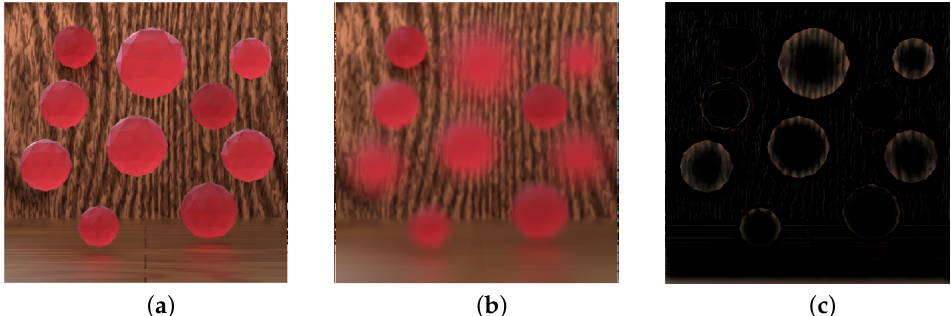
Figure 8. ( a ) The all-in-focus image, ( b ) the image in the focal stack focused on the background, and ( c ) background region minus the effect of the foreground object